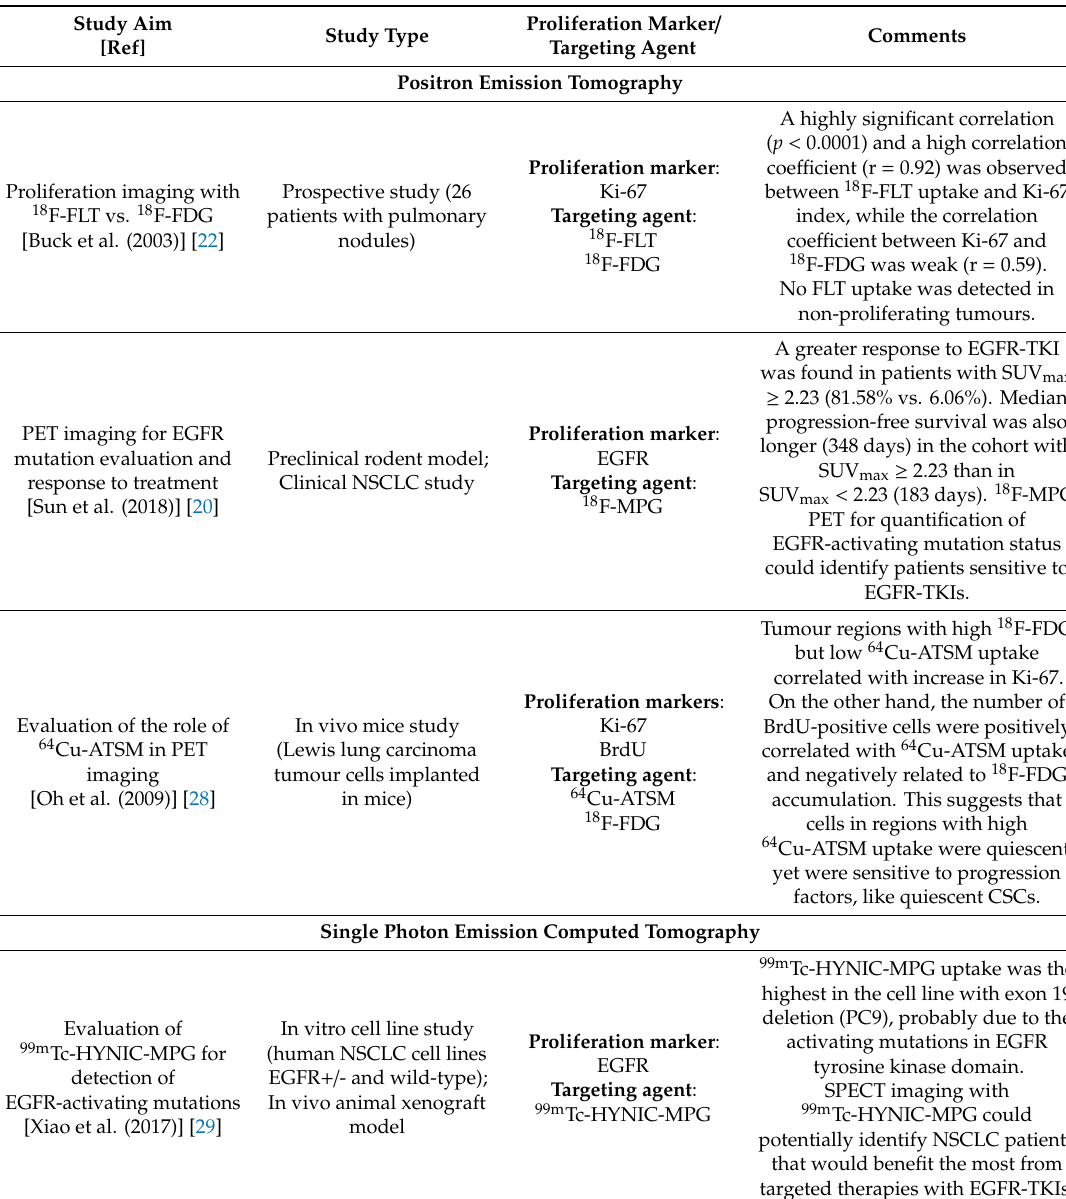
Table 1 is a compilation of di ff erent functional imaging agents tested as markers for tumour proliferation in NSCLC. Table 1. Functional imaging biomarkers for tumour proliferation in non-small cell lung cancer